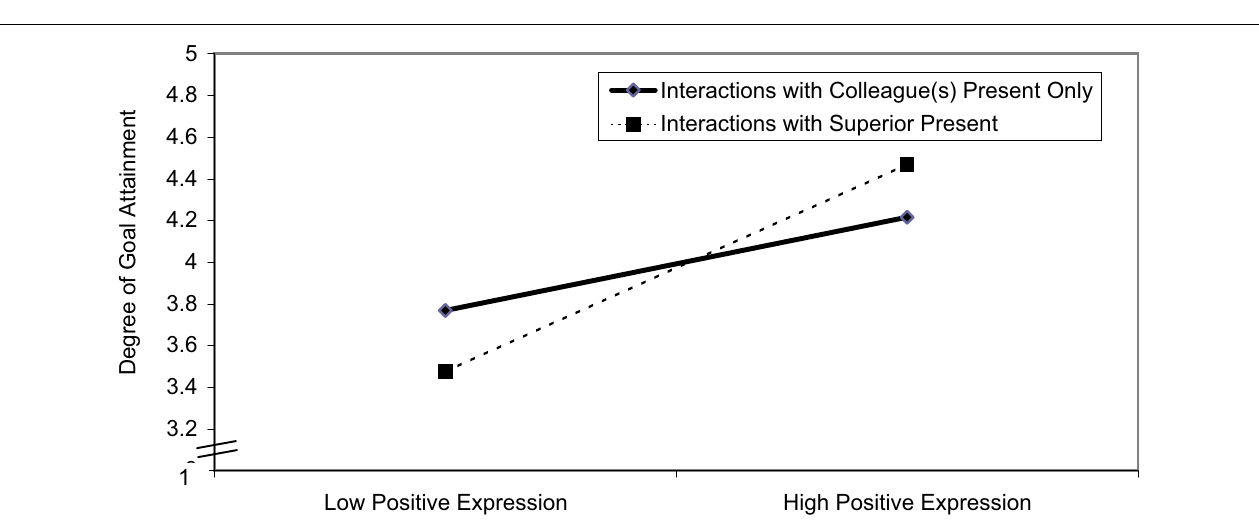
FIGURE 1 | Predicting goal attainment by expressing positive emotions during interactions at work with a superior present versus not